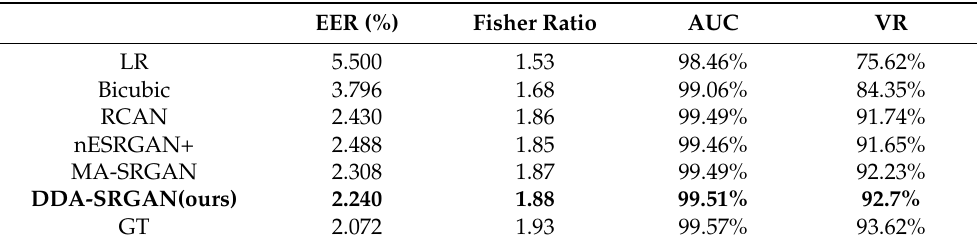
Figure 12. Comparison of ROC curves for each SR model on the CASIA-Iris dataset. The figure shows the various SR methods, and the deep-learning-based approaches show the outstanding performance compared to the traditional method (bicubic). Furthermore, the proposed DDA-SRGAN achieves the best performance and narrows the gap between the SR method and ground truth (GT). Table 4. The comparison with different SR method in iris